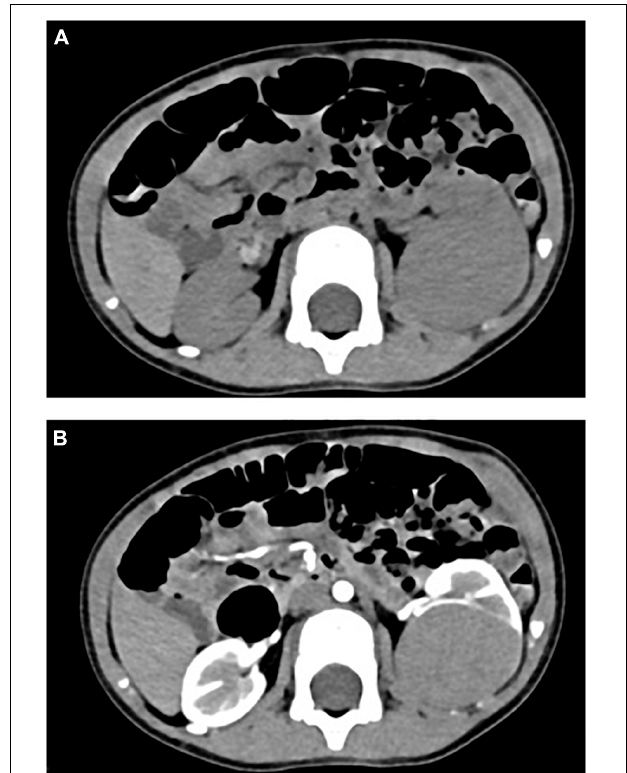
( Figure 3 ). Neuron-specific enolase (NSE) assay was 25.71 ng/ml